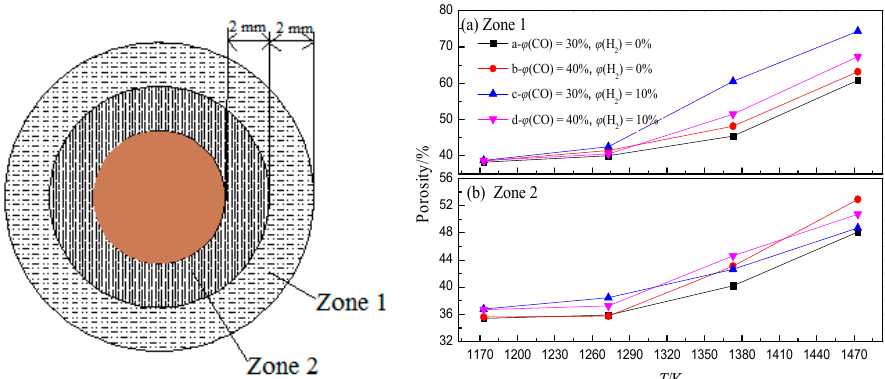
Figure 6. Effects of H 2 on reduction degree of iron ore and coke gasification rate under different conditions, adopted from [67]. ( a ) φ ( CO ) = 30%; ( b ) φ ( CO ) = 40%.